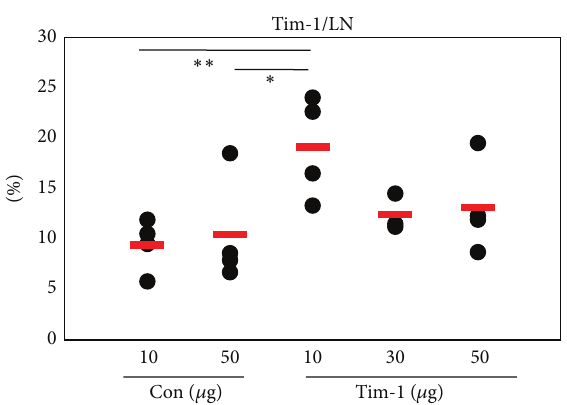
Figure 3: Administration of Tim-1 vector increased the frequencies of Tim-1 + cells. The Tim-1 vector was injected intraperitoneally at 10, 30, and 50 𝜇 g/mouse into Nor mice twice at 2 day intervals to observe up-regulation of Tim-1 expression. The day of the last injection, the frequencies of Tim-1 + cells in LN were compared to the control vector injected group by FACS analysis. The control was injected with the pCDEF3 empty vector (10 or 50 𝜇 g/mouse) ( 𝑛 = 3- 4) ( ∗∗ 𝑃 < 0.05 ). Con: control vector injection to normal (Nor) mice, Tim-1: Tim-1 vector injection to Nor